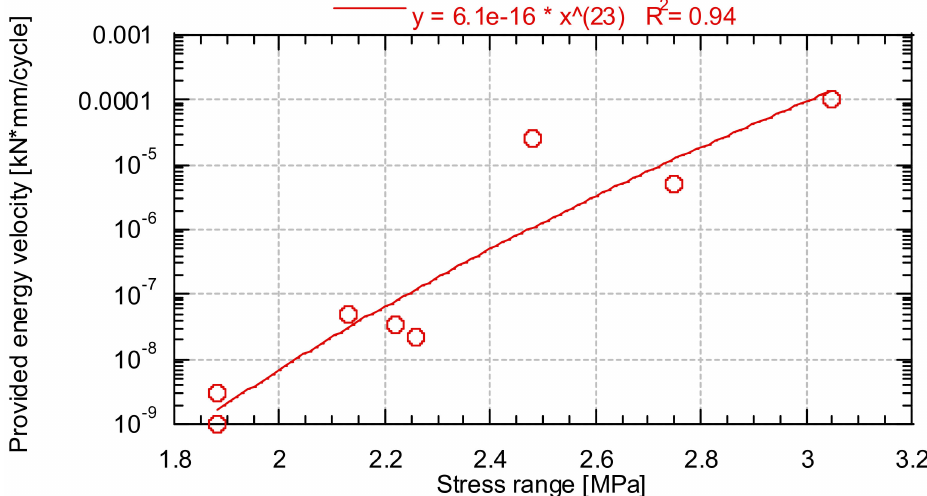
Figure 18. Provided energy velocity as a function of the test stress